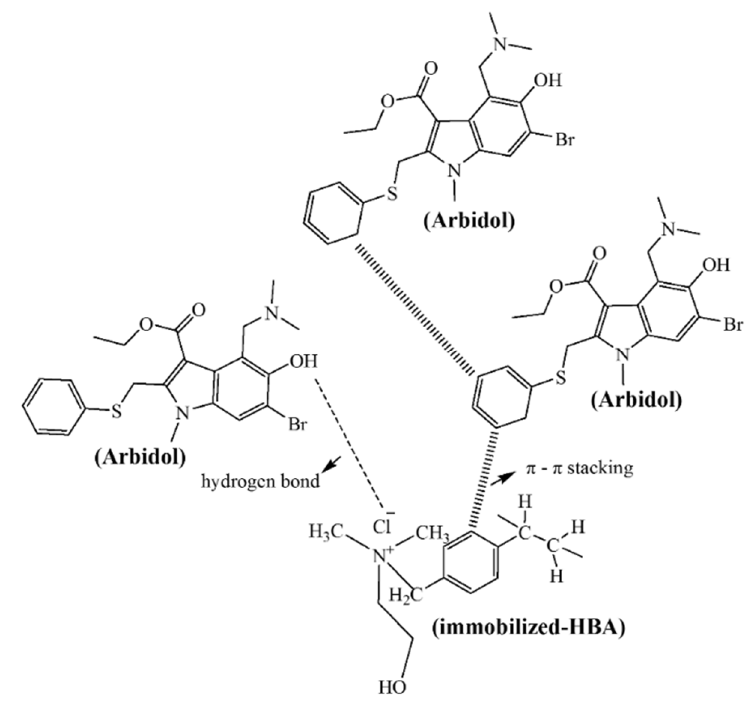
Figure 6. The adsorption mechanism of arbidol by immobilized-HBA.